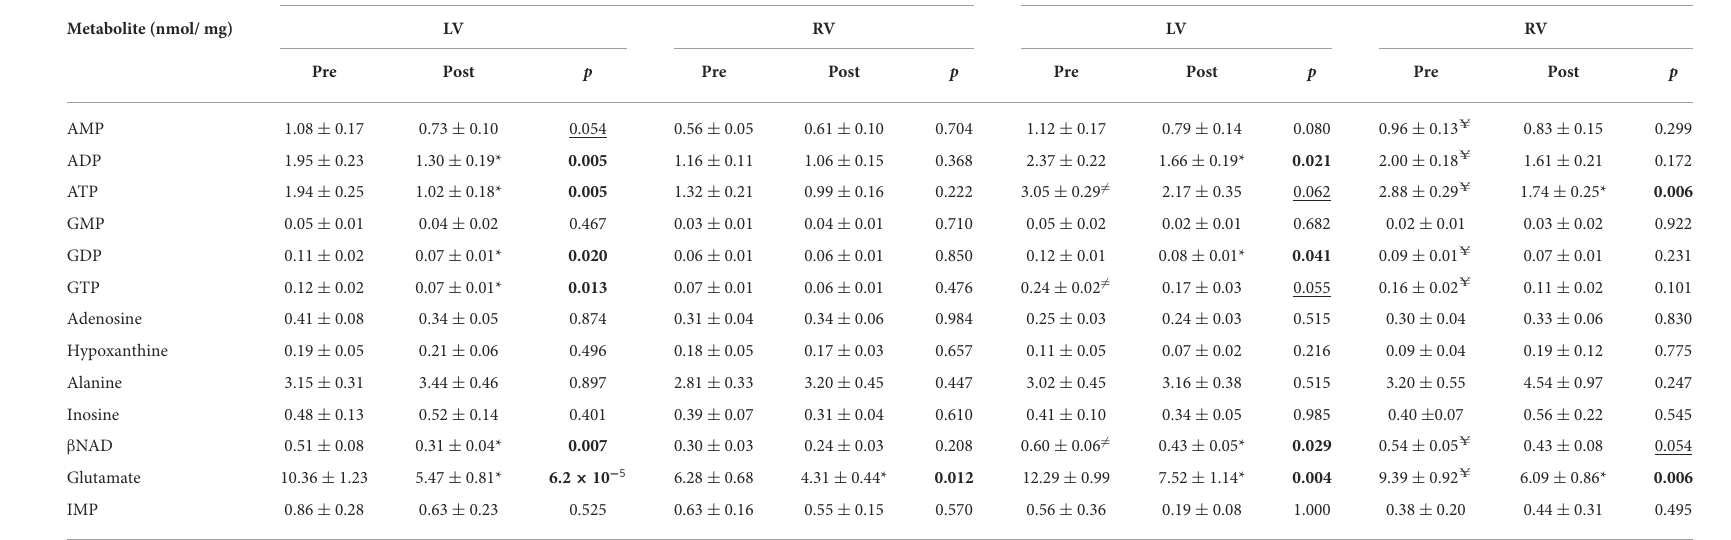
TABLE 3 Concentration of metabolites before and after surgery in LV and RV of CABG and AVR